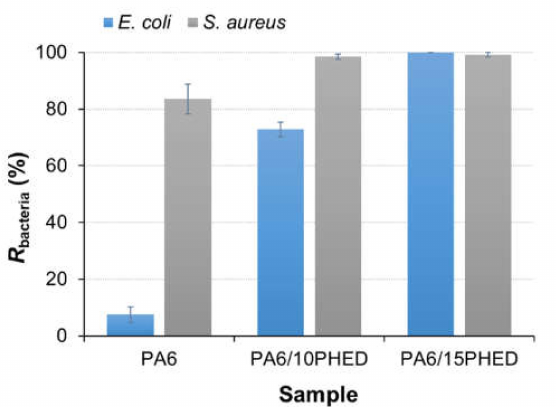
Figure 2. Bacterial reduction, R bacteria , of E. coli and S. aureus obtained for the inoculums that were in contact with the PA6, PA6/10PHED, and PA6/15PHED fiber samples. The error bars represent the standard error of the mean. PA6: polyamide 6, PA6/10PHED and PA6/15PHED: PHED in the PA6 matrix during the in situ polymerization process at concentrations equal to 10 and 15 wt %, respectively.